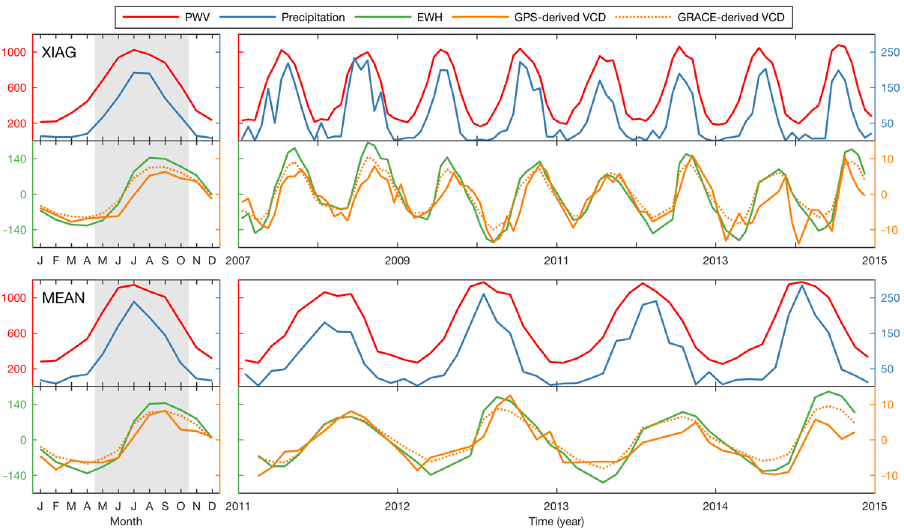
Figure 2. Mean annual signals (left panels) and monthly time series (right panels) of PWV, precipitation, EWH, GPS-derived and GRACE-derived VCD at XIAG (upper panels) station and for the mean time series of 25 stations from 2011.0 to 2015.0 (MEAN, lower panels). To facilitate comparison with EWH, positive deviation of VCD means downward movement. All of these quantities are in millimeters. The gray rectangles indicate the monsoon